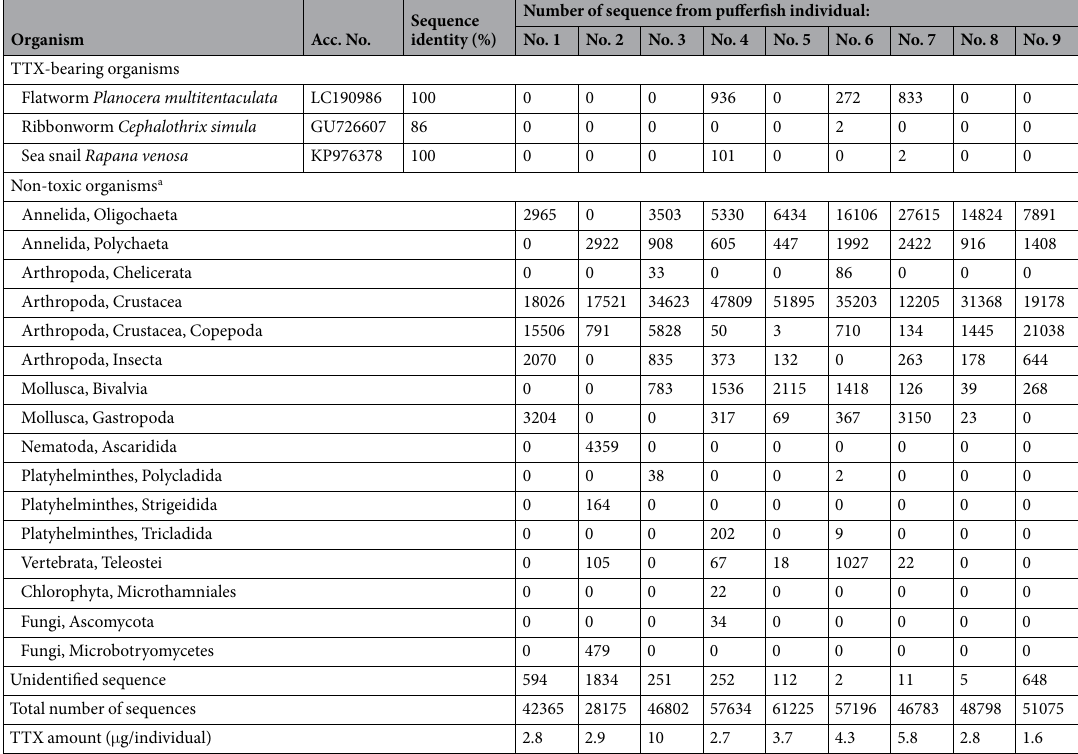
Table 3. DNA sequences from the intestinal contents of the pufferfish Takifugu niphobles juveniles collected at Katase in July 2017. The pufferfish juveniles were randomly selected from the specimens collected at Katase in July 2017, shown in Table 1. a The list of sequences from non-toxic organisms are shown in the supplementary data (Table